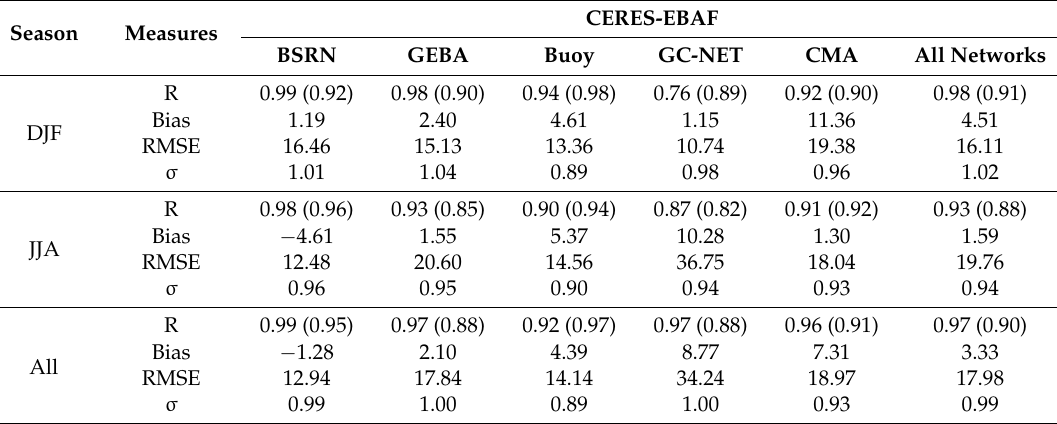
Figure 3. Spatial distributions of model biases ( a ) and RMSE ( b ) between surface observed R s at 674 sites and R s obtained from CERES-EBAF R s products. Units are W/m 2 . Table 5. Evaluation of the monthly R s from CERES-EBAF data using surface measurements collected from 674 stations from 2001 to 2009. The numbers in the brackets are the correlation coefficients after removing the seasonal cycle. Units are W/m 2 for bias and